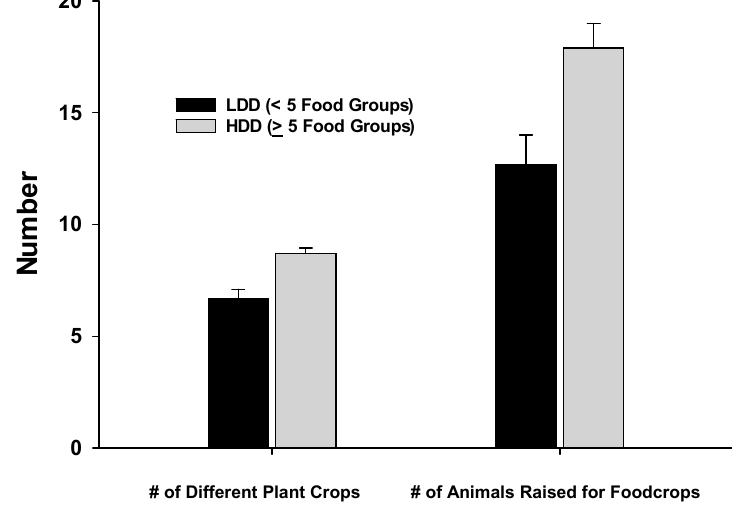
Figure 2. Number of different types of plant food crops cultivated and total number of animals raised by women who exhibited low dietary diversity (LDD: <5 food groups) compared to women with higher dietary diversity (HDD > 5 food groups consumed). Differences were significant at p < 0.05.